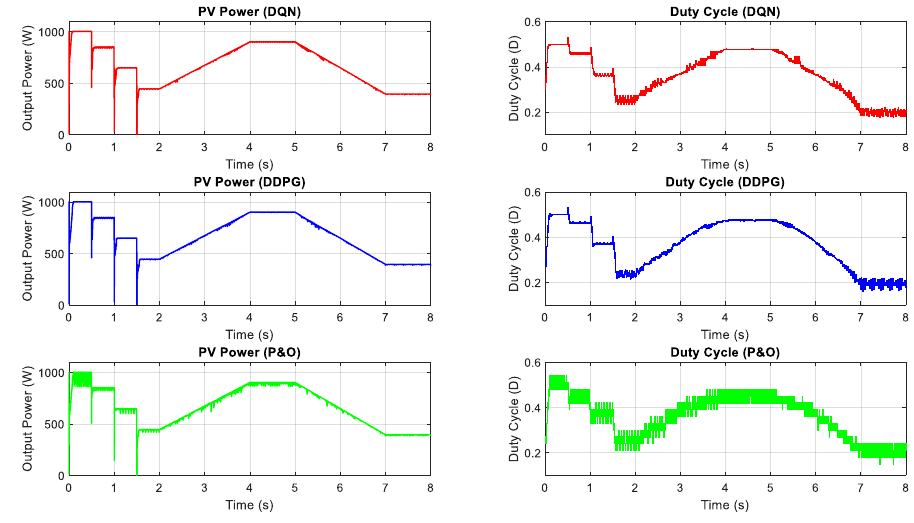
Figure 8. PV power under the change of irradiation.